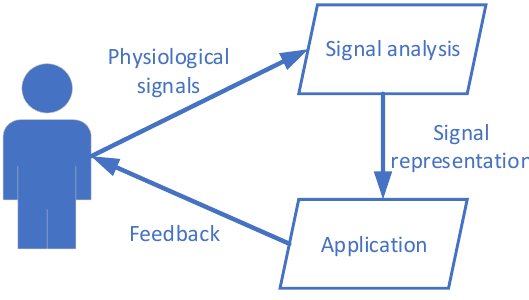
Figure 1. A general scheme of biofeedback.